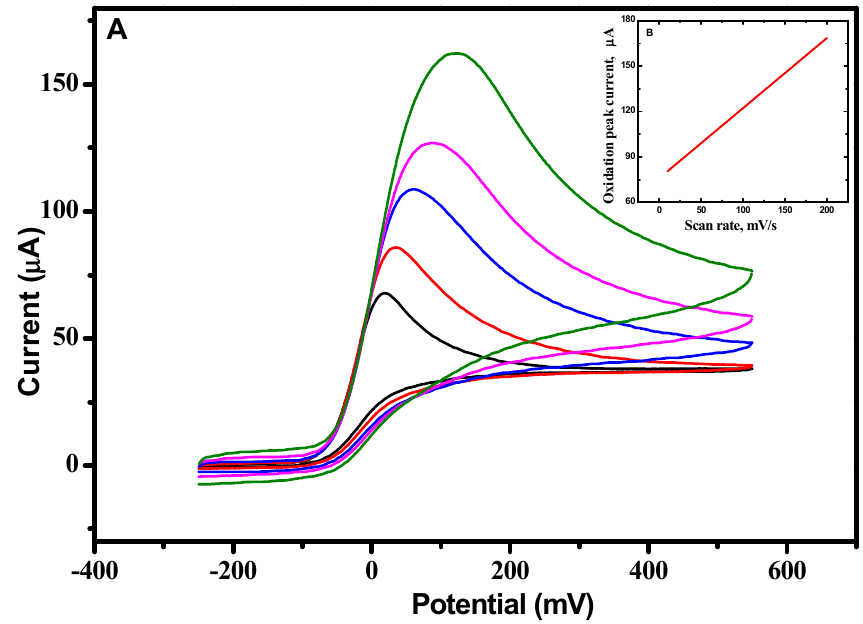
Figure 7. ( A ) CVs were obtained at a RSNMC/GC electrode in 3 mM Ascorbic acid prepared in PBS, pH 7.0 at 10, 20, 50, 100, and 200 mVs − 1 scan rates; and ( B ) relationship between peak current and scan rate.